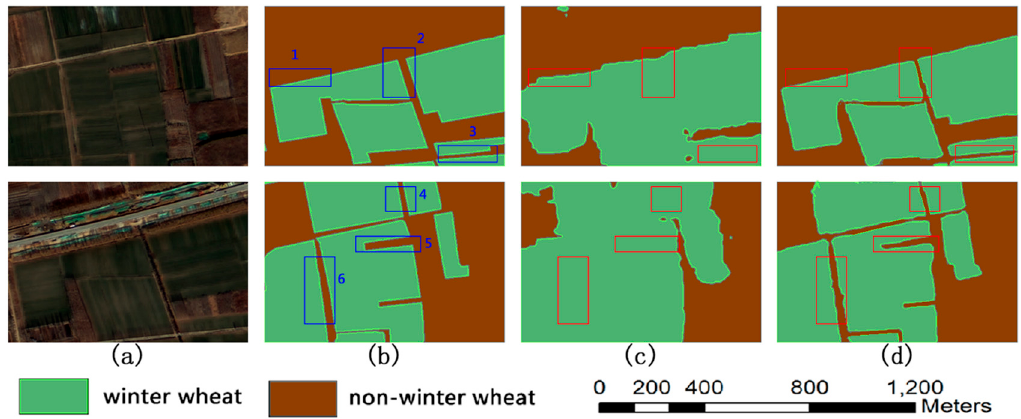
Figure 9. Segmentation error comparison: ( a ) original images, ( b ) ground truth, ( c ) errors of SegNet results, and ( d ) errors of CEM results.